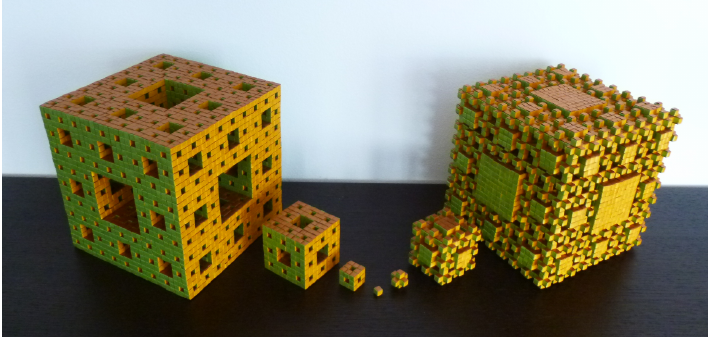
Figure 12. Menger sponges and complements until third